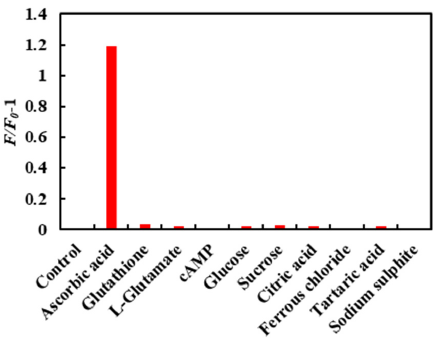
Figure 7. Effect of different biomolecules on the fluorescence intensity of the CDs/Fe 3+